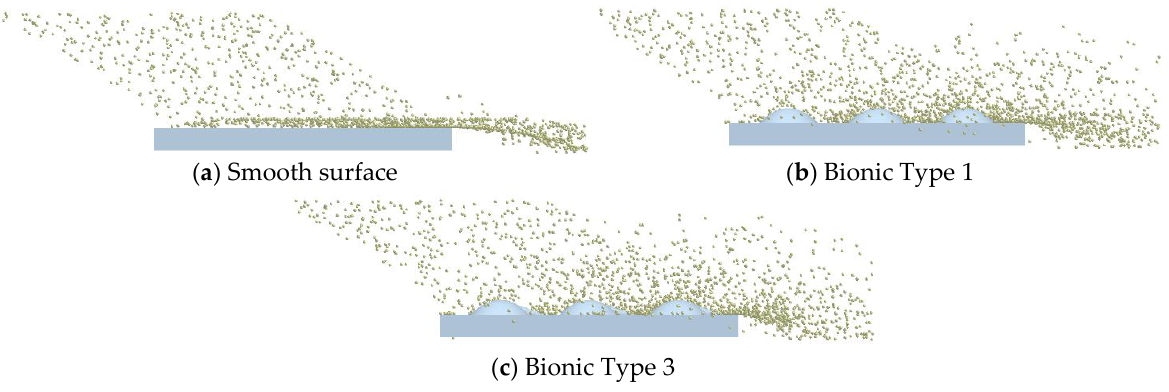
Figure 12. Interaction between abrasive particles and different types of surfaces by EDEM numerical simulation.